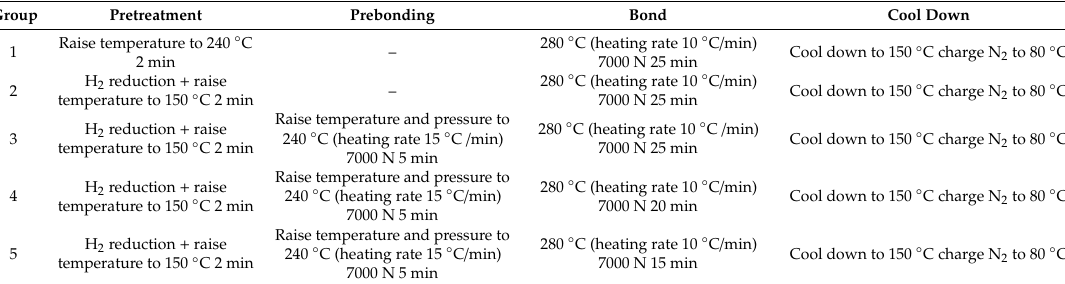
Table 3. Parameter settings of di ff erent wafer-level